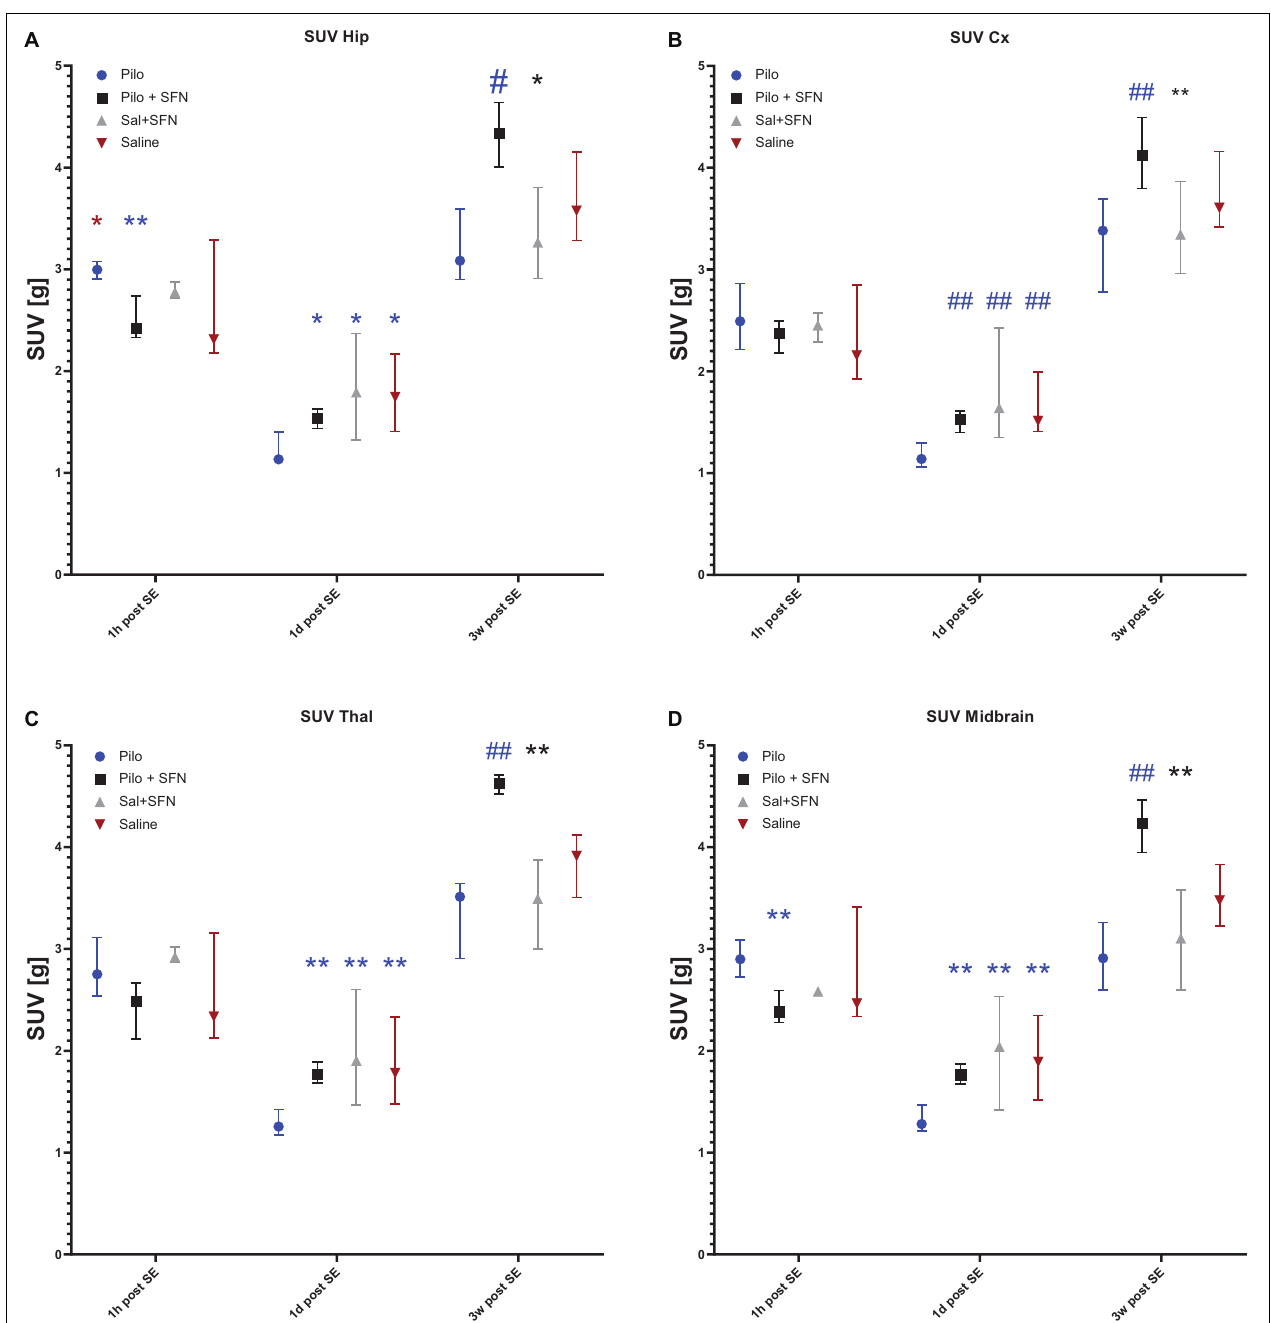
FIGURE 5 | SFN pretreatment reverses changes in glucose uptake and enhances recovery after SE in all the macro-ROIs. In the hip (A) and midbrain (D) , macro-ROIs differences between the groups appeared in the earliest time point (Kruskal–Wallis test P < 0.05) while SFN attenuated glucose uptake increase 1 h post SE. Additionally, SFN influenced glucose uptake in all the ROIs (A–D) both 1 day and 3 weeks post SE (Kruskal–Wallis test P < 0.05 in all the macro-ROIs in both time periods). Symbols in the graph come from post-hoc Dunn’s multiple comparisons test that was conducted if the differences on the Kruskal-Wallis test had shown significant. The colour of the symbol denotes the group the comparison was made to, and the location of the symbol denotes which was the other group. All values are reported as median ± interquartile range (* P < 0.05, ** P < 0.01, # P < 0.001, ## P < 0.0001).